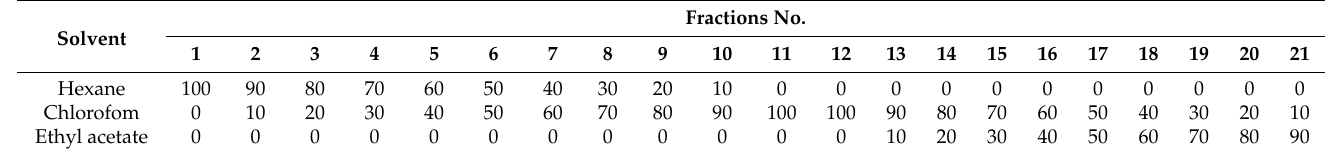
Table 2. Total fractions obtained from chromatographic column fractionation. Fractions